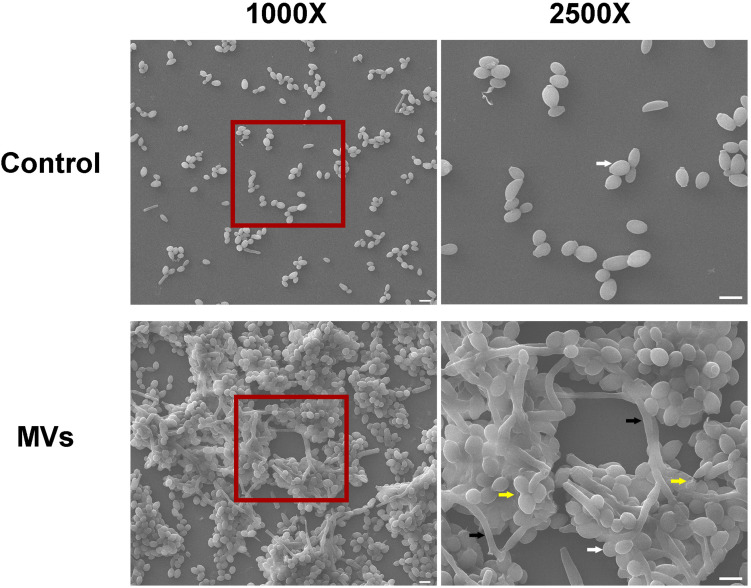
Morphological characteristics of C. albicans 24-h-old biofilms. Each field of vision was magnified 1,000 × and 2,500 ×. The red boxes indicate the magnified viewing area. The white arrows show the yeast cells, the black arrows show the hyphal cells, and the yellow arrows indicates the biofilm extracellular matrix. Scale bar, 5 μm.